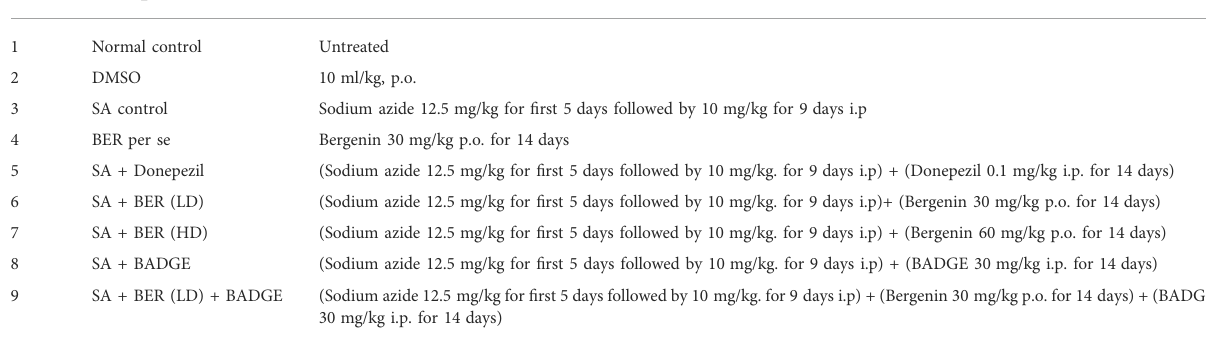
TABLE 2 Details of different treatment